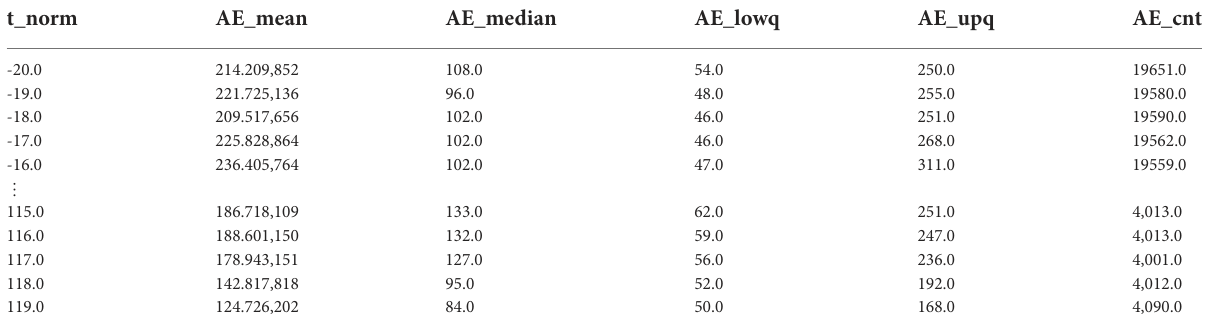
TABLE 1 Anexamplearrayforwhen sean() isusedtoperforma1DsuperposedepochanalysisonAEdataonly,usingthedefaultstatistics.